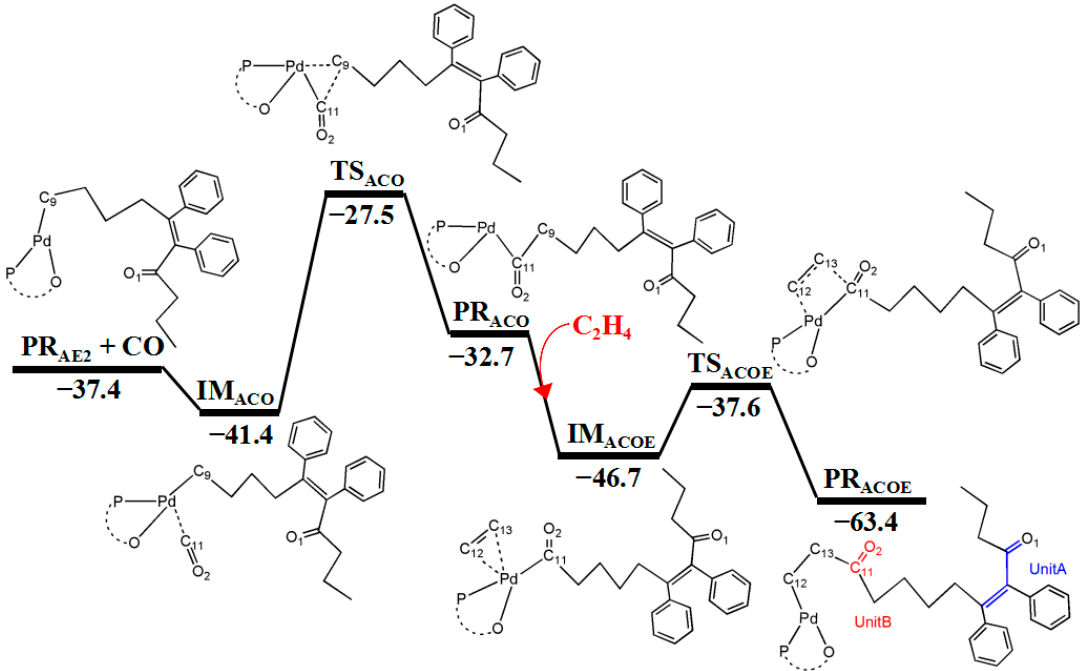
Figure 9. The reaction pathway for generation of UnitB; the relative free energy is given in kcal/mol.